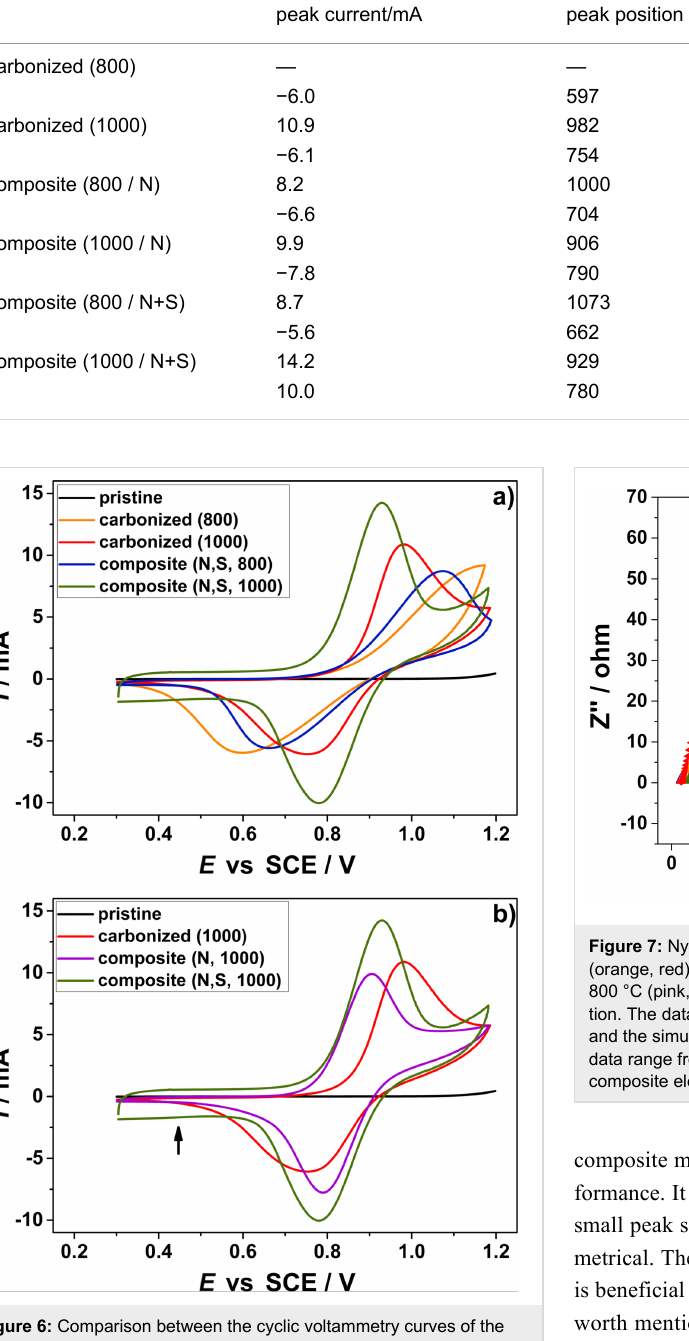
heteroatom-containing functional groups [17,29]. Similar be- havior could be noted here, with heteroatoms into the carbon felt an increase in activity is observed. Especially, the co-doped